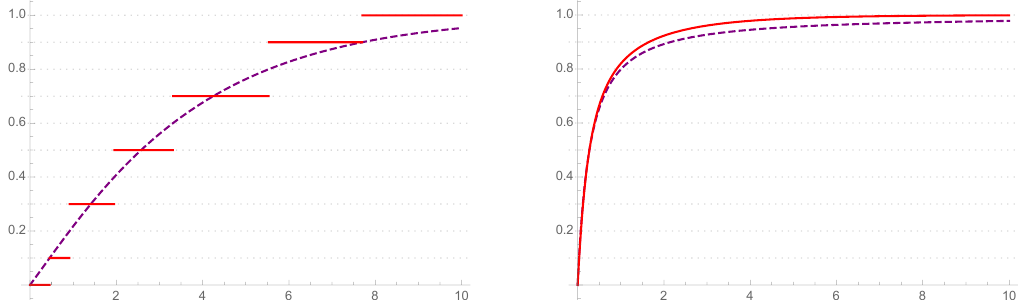
Figure 1. Approximating the ladder height distribution with a hyperexponential one with 6 phases to achieve accuracy (cid:101) = 0.1, under Pareto ( 2,3 ) claim sizes. On the left graph, the purple dashed line corresponds to the spectral cdf S H and the red solid line to its approximate step function ˆ S H , whereas on the right graph we see H and ˆ H ,